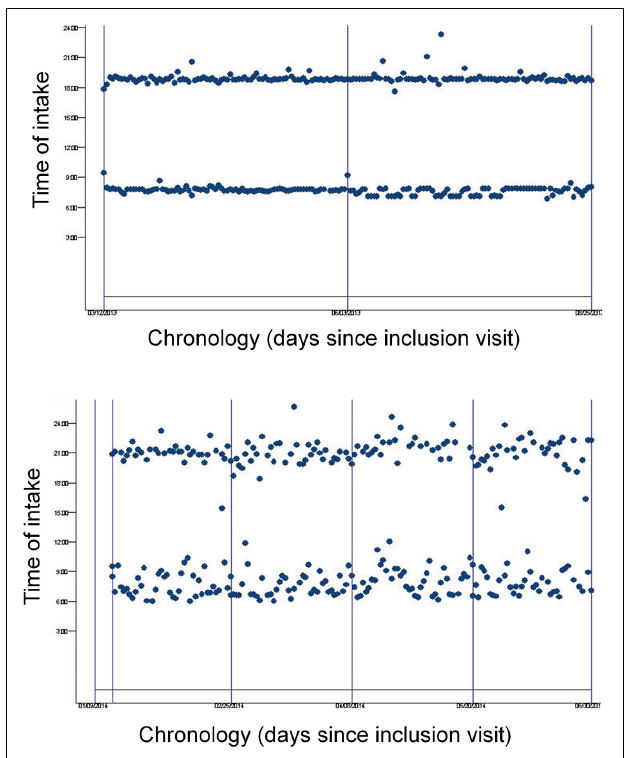
FIGURE 5 | Dosing chronology plot used to visualize the dosing history of two patients on ticagrelor b.i.d [Patient 1 (upper) , Patient 2 (lower) ]. Dosing chronology plot of two participants. The horizontal axis displays the days since the inclusion visit. The vertical axis shows the time of drug intake (24 h clock; dosing time). Dots represent opening of the electronic monitor (Medication Event Monitoring System-MEMS R (cid:13) ).